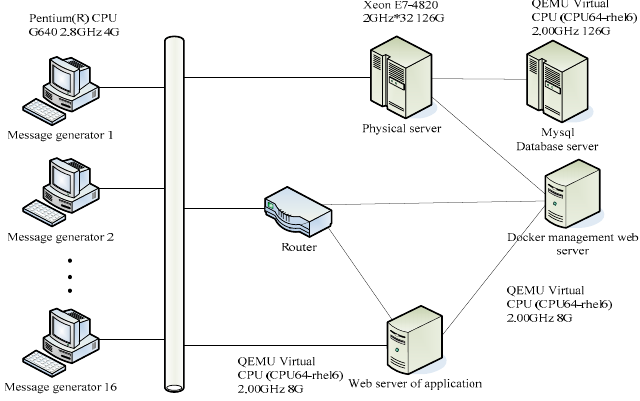
Figure 6. Configuration of the experimental environment.